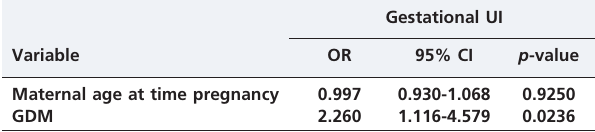
Table 2 - Estimated ß parameter, odds ratio (OR), 95% confidence interval (95% CI) and p-value obtained by adjusting the multivariate logistic model for investigating decresead of VSP two years after GDM.